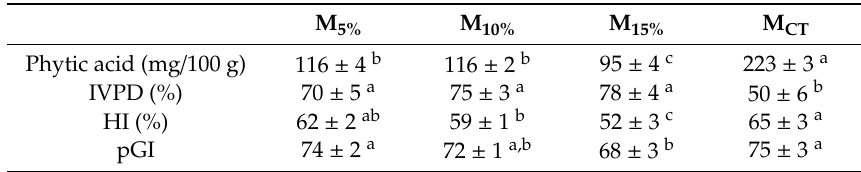
Table 3. Phytic acid, IVPD and HI of the te ff mu ffi ns: M 5% , mu ffi n containing 5% (wt / wt) type-I sourdough; M 10% , mu ffi n containing 10% (wt / wt) type-I sourdough; M 15% , mu ffi n containing 15%